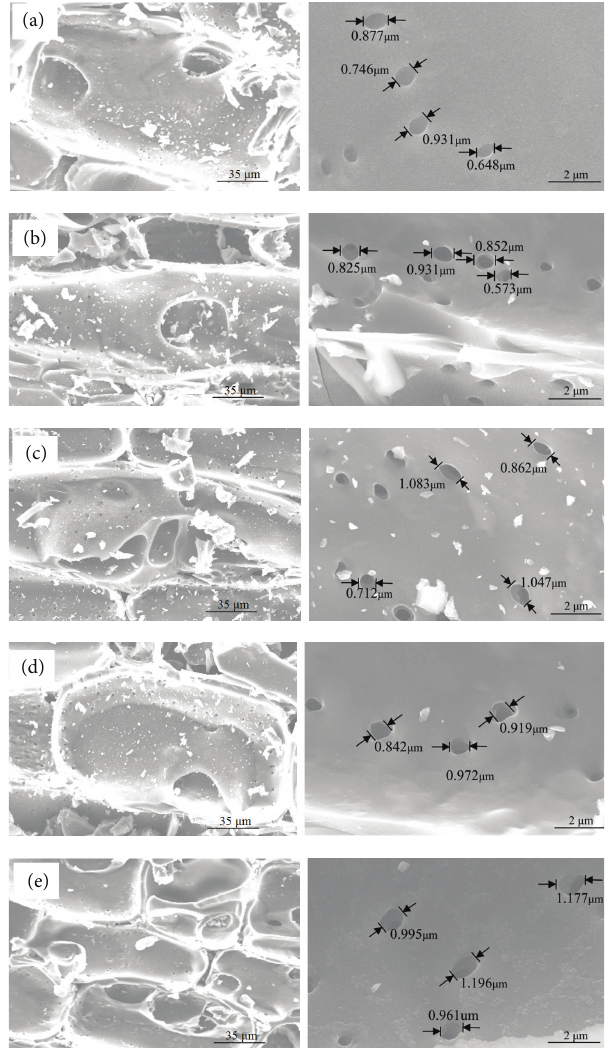
Figure 3: Thecal pore structure of charcoal carbonized at temper- atures of (a) 600, (b) 700, (c) 800, (d) 900, and (e) 1000 ∘ C (left: radial section of thin-walled cells of charcoal, right: distributions of micropores in cavern